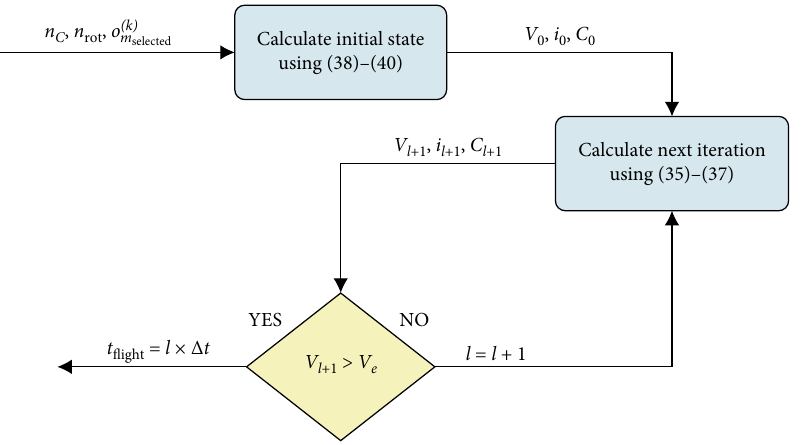
Figure 7: Power system calculation flowchart for 𝑘 th operating point.